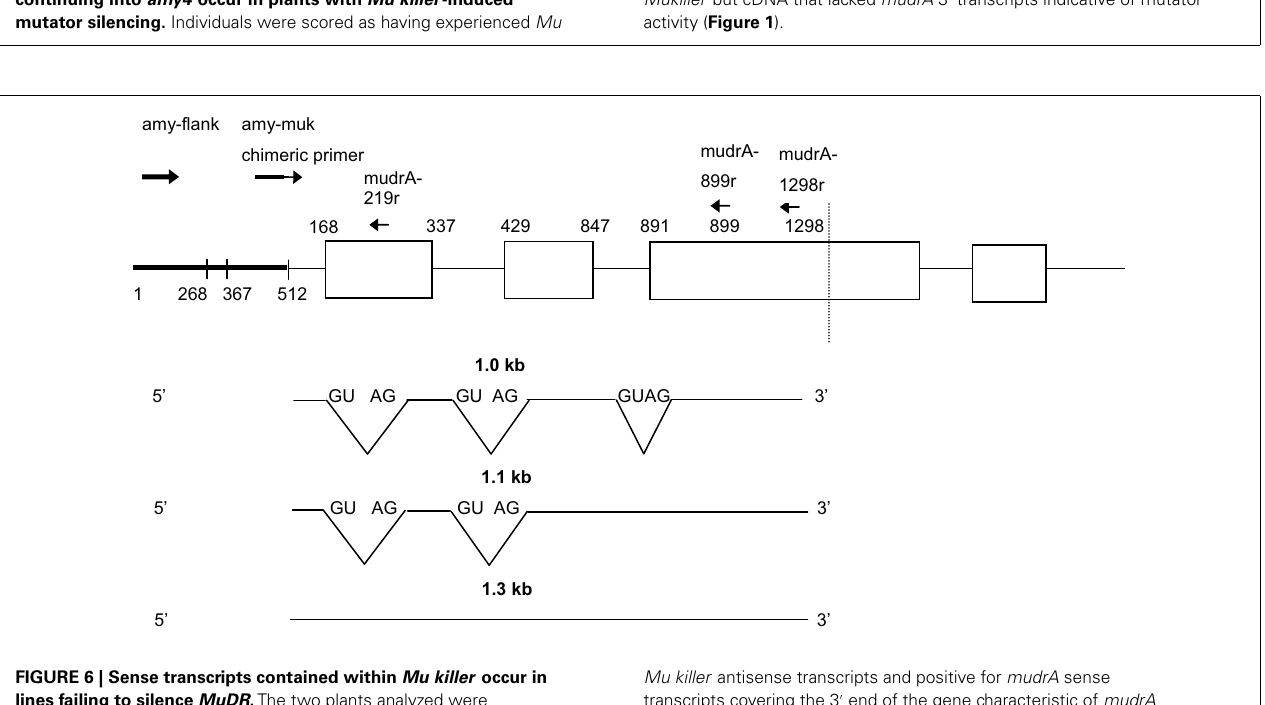
Mu killer antisense transcripts and positive for mudrA sense transcripts covering the 3 (cid:48) end of the gene characteristic of mudrA ( Figure 1